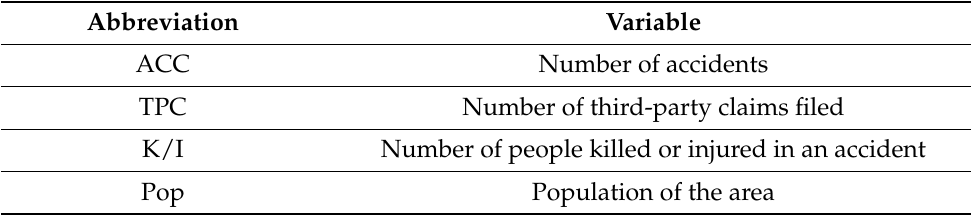
Table 1. Variable